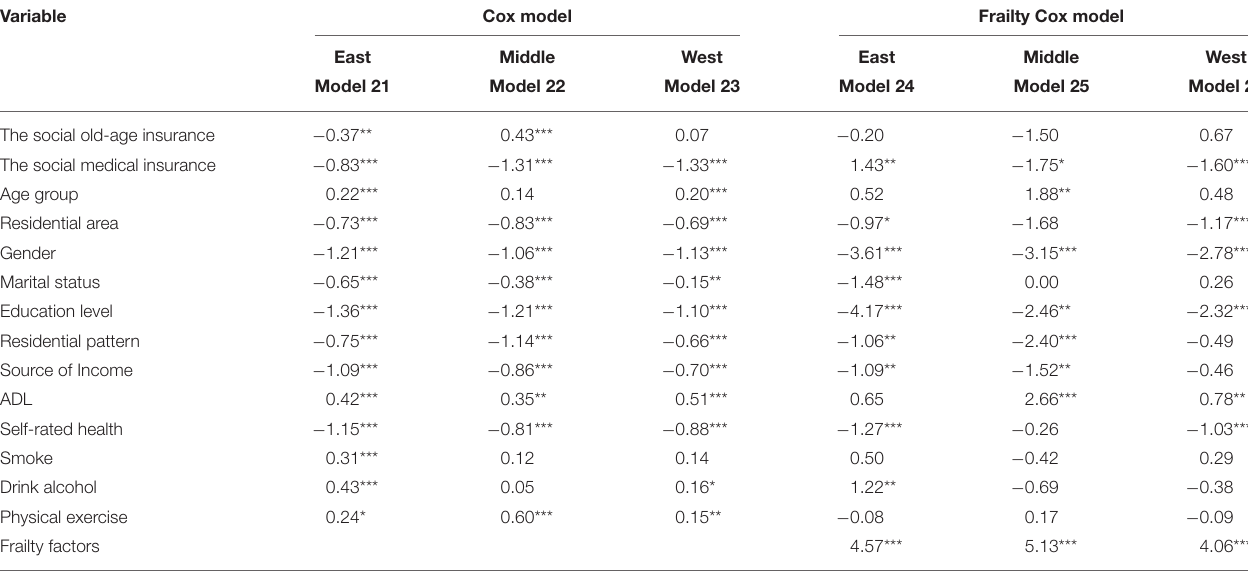
TABLE 5 | The regression results of the Cox model and the frailty Cox model under the samples of different regions.